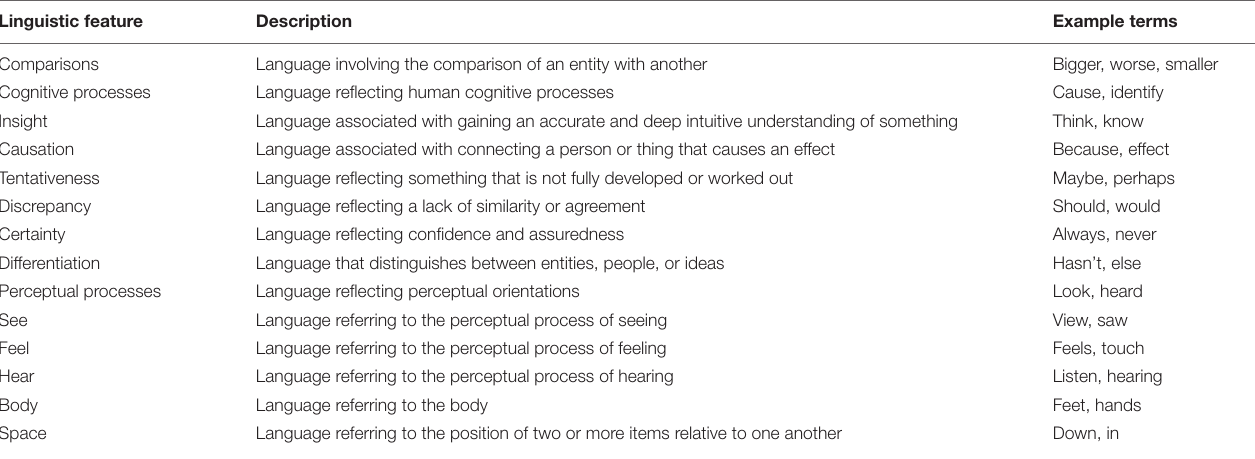
TABLE 5 | Linguistic inquiry and word count (LIWC) categories examined in reasoning